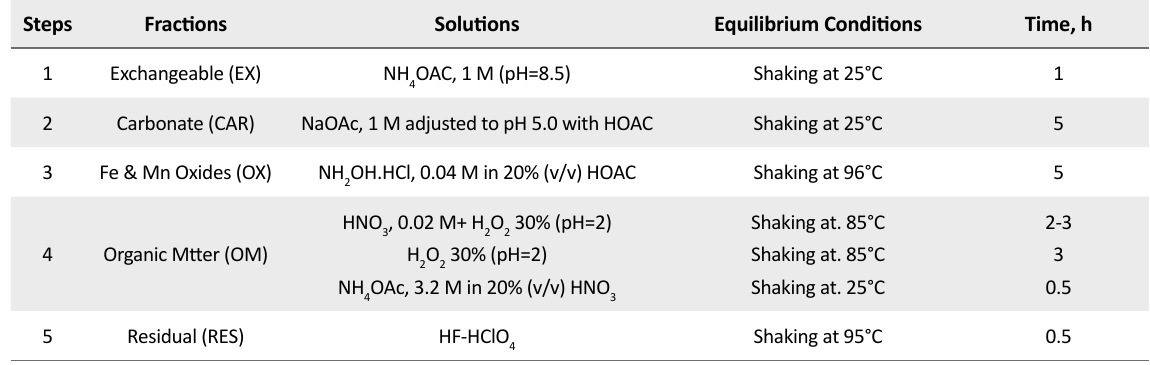
Table 1. Summary of the Tessier sequential extraction procedure used in this study [24] Steps Fractions Solutions Equilibrium Conditions